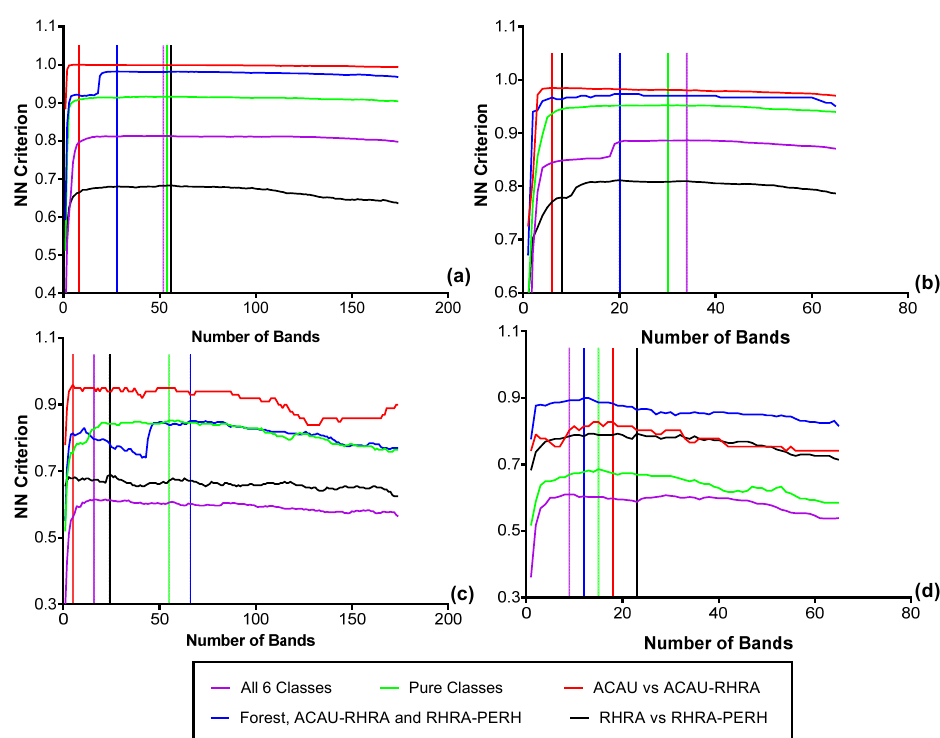
Figure 11. Optimal bands from the FFS for discriminating the six predominant species classes from ( a ) VNIR reflectance (2.5 m), ( b ) SWIR reflectance (2.5 m), ( c ) VNIR reflectance resampled to the coarsest SCM spatial (62.5 m), ( d ) SWIR reflectance resampled to the coarsest SCM spatial resolution (62.5 m).